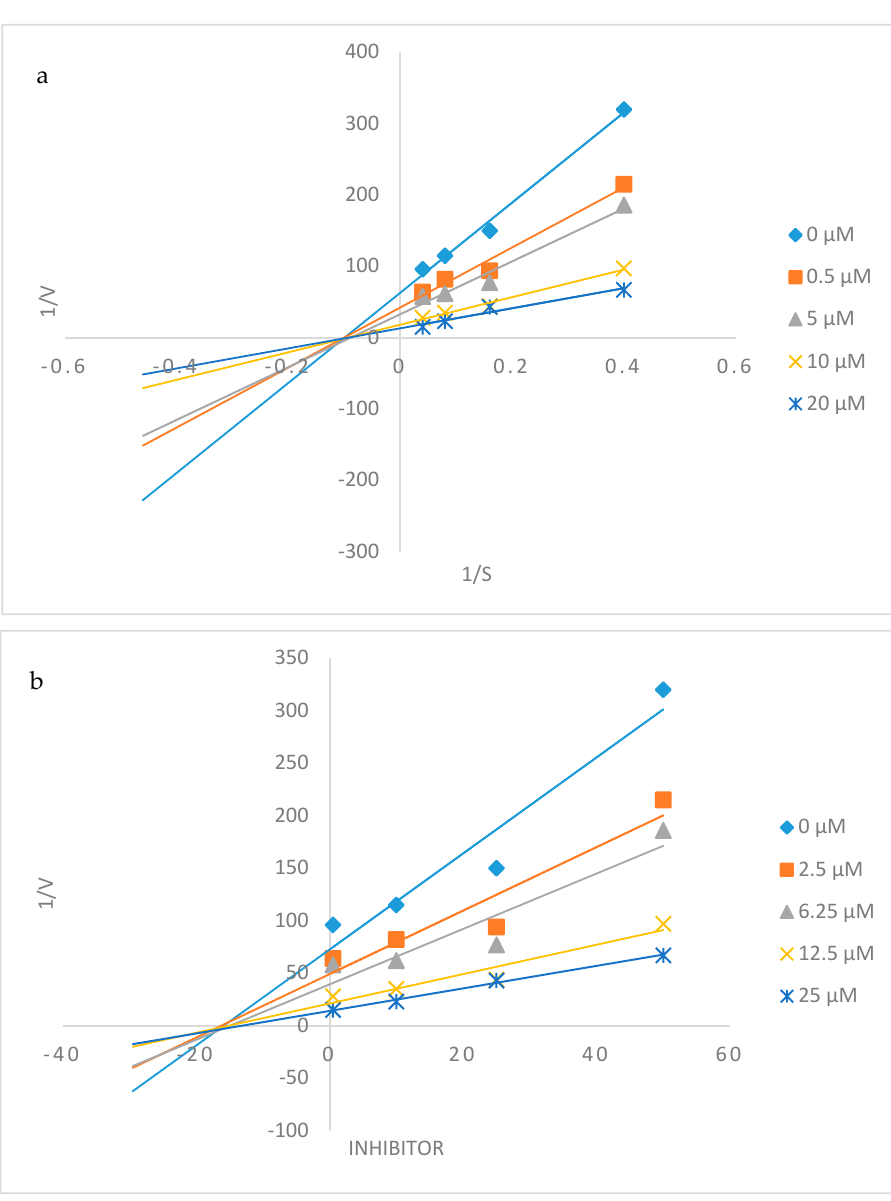
Figure 2. Lineweaver–Burk ( a ) and Dixon ( b ) plots for the inhibition of α -glucosidase by compounds 2c .